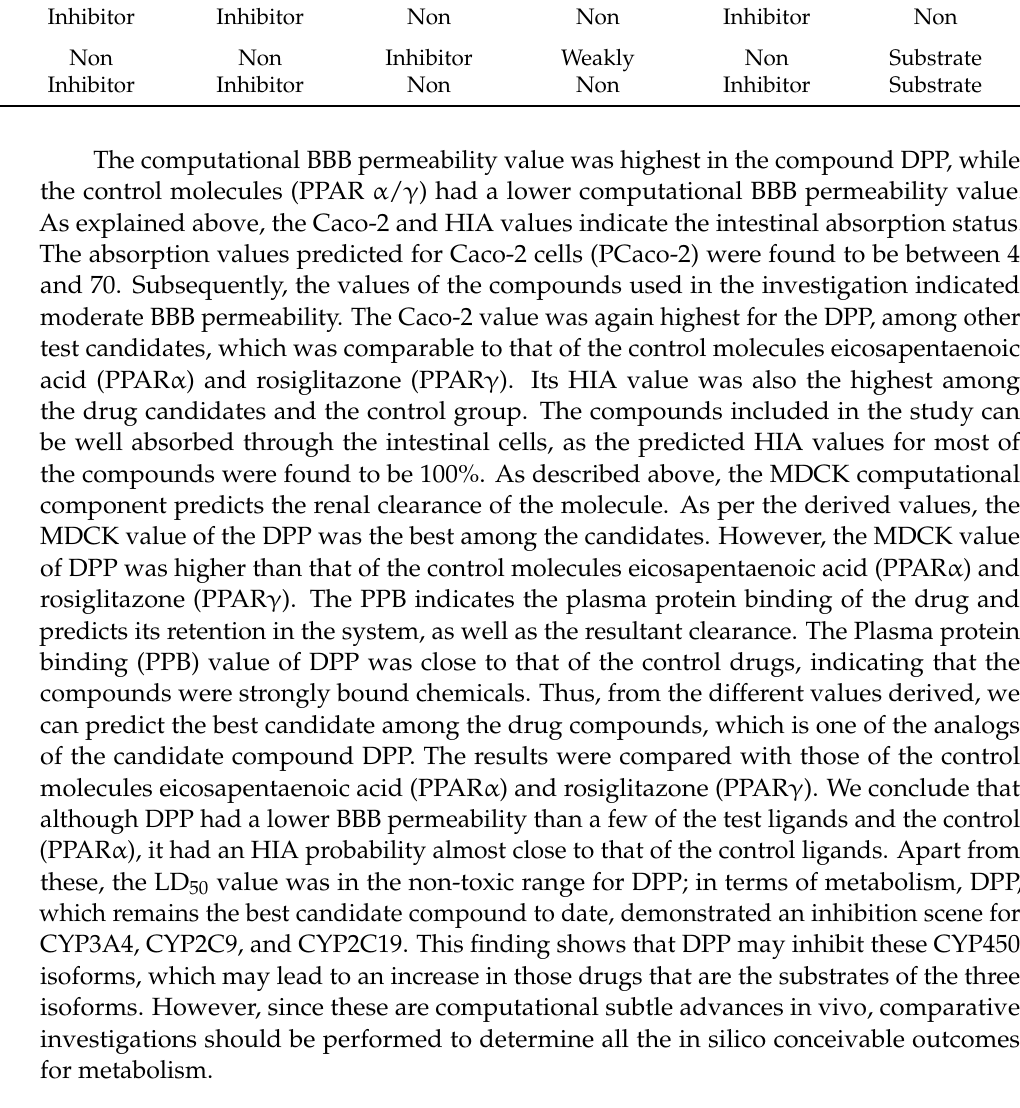
CYP2C19 CYP2C9 CYP2D6 CYP2D6 CYP3A4 CYP3A4 Inhibition Inhibition Inhibition Substrate Inhibition